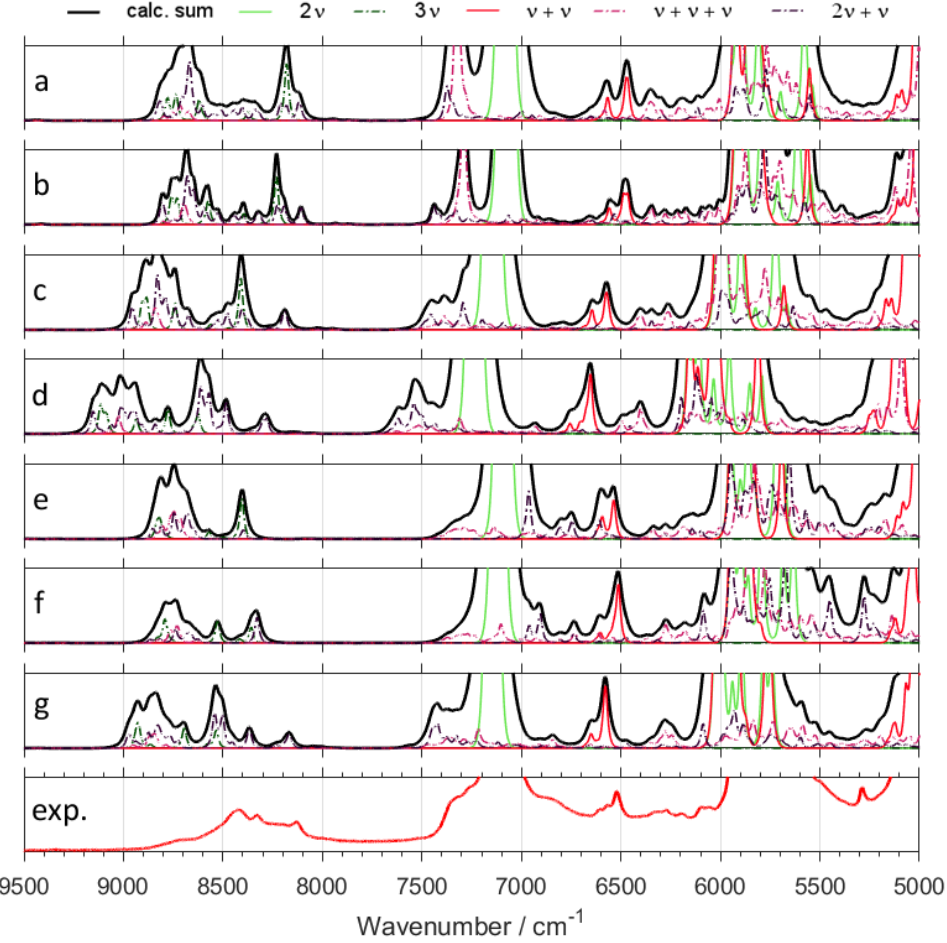
Figure 3. Contributions from minor bands in NIR spectra of CH 3 CH 2 OH calculated with GVPT2 method at different levels of electronic theory; ( a ) B3LYP-GD3BJ/6-31G(d,p); ( b ) B3LYP-GD3BJ/6-31G(d,p)//CPCM; ( c ) B2PLYP-GD3BJ/6-31G(d,p)//CPCM; ( d ) MP2/6-31G(d,p)//CPCM; ( e ) B3LYP-GD3BJ/SNST//CPCM; ( f ) B2PLYP-GD3BJ/def2-TZVP//CPCM; ( g ) MP2/aug-cc-pVTZ//CPCM; ( exp. ) Experimental spectrum of CH 3 CH 2 OH in CCl 4 (0.1 M).